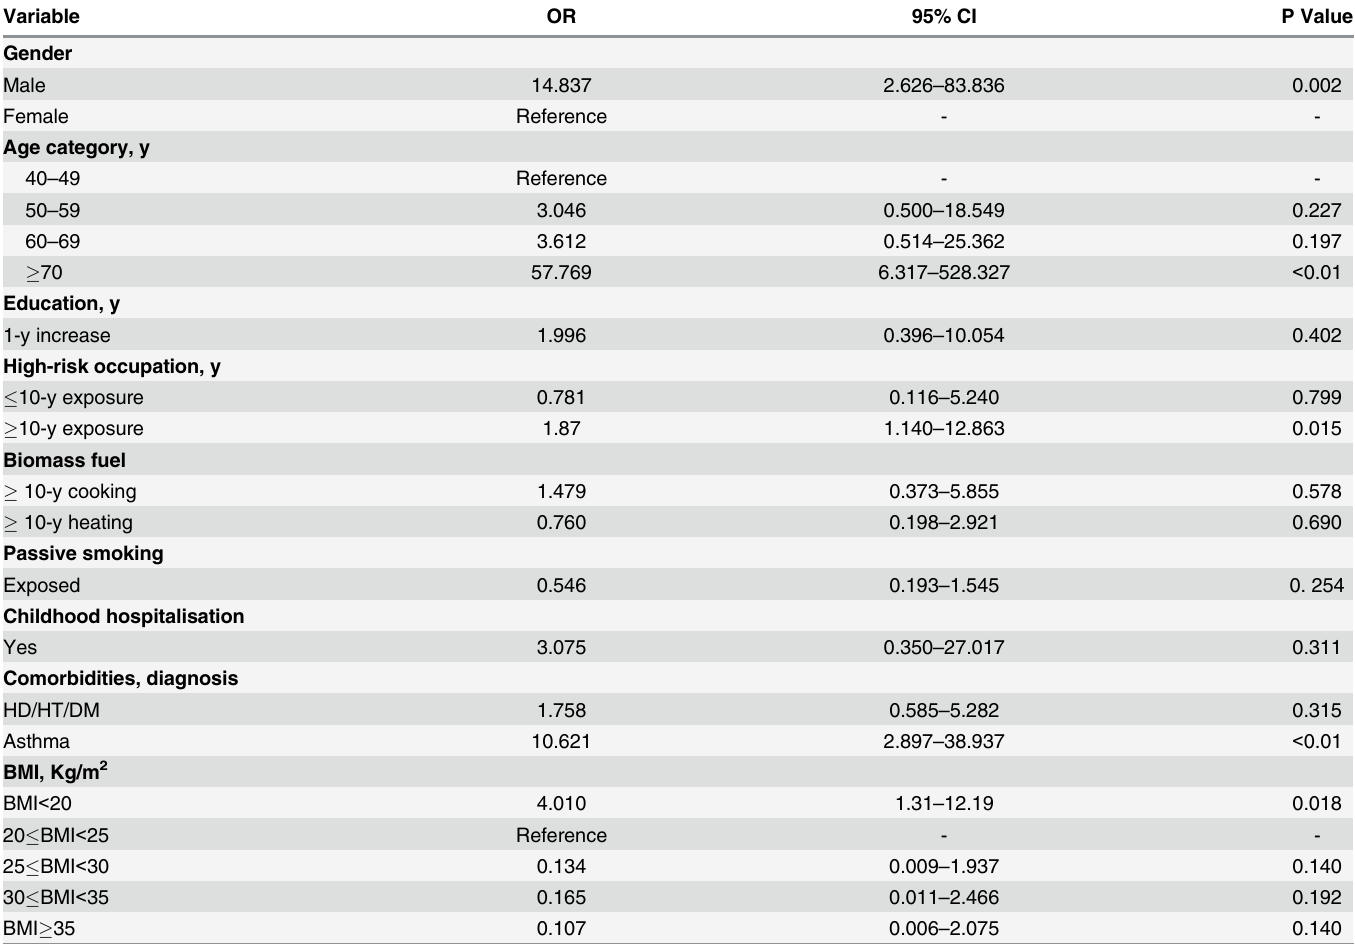
Table 5. Independent predictors of GOLD stage I+ COPD in nonsmokers: Multivariate logistic model. Variable OR 95% CI P